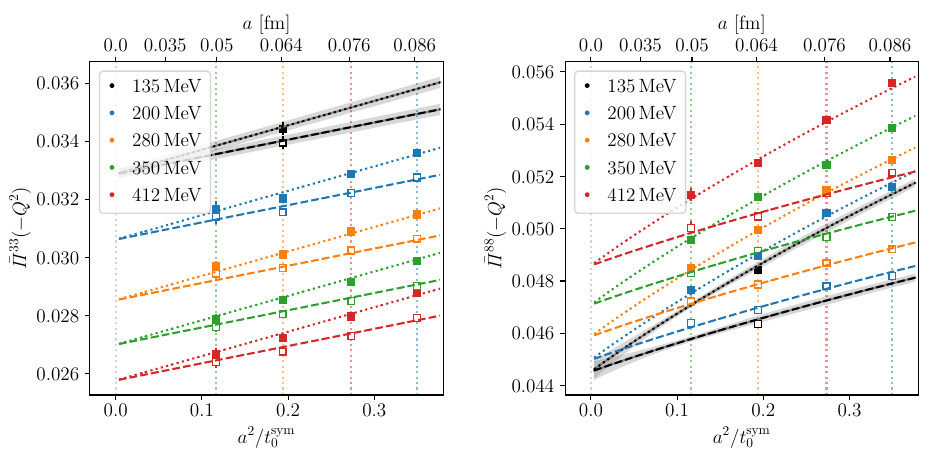
Figure 7 . Plots of ¯ Π 33 ( − Q 2 ) at Q 2 = 1 GeV 2 (left) and ¯ Π 88 ( − Q 2 ) at Q 2 = 5 GeV 2 (right) on different ensembles as a function of the lattice spacing, together with the results of the combined fit. (cid:0) (cid:1) The left panel shows an example in which the O a 2 fit model is used, while a term proportional to a 3 has been included in the right plot as well. Different colors distinguish different pion masses from a set of five reference values. Using the functional form determined by the fit, each data point has been shifted to the closest value of φ 2 matching one of the reference pion masses, and to the same value of φ 4 . Filled symbols and dotted lines denote the conserved-local discretization, while open symbols and dashed lines denote the local-local